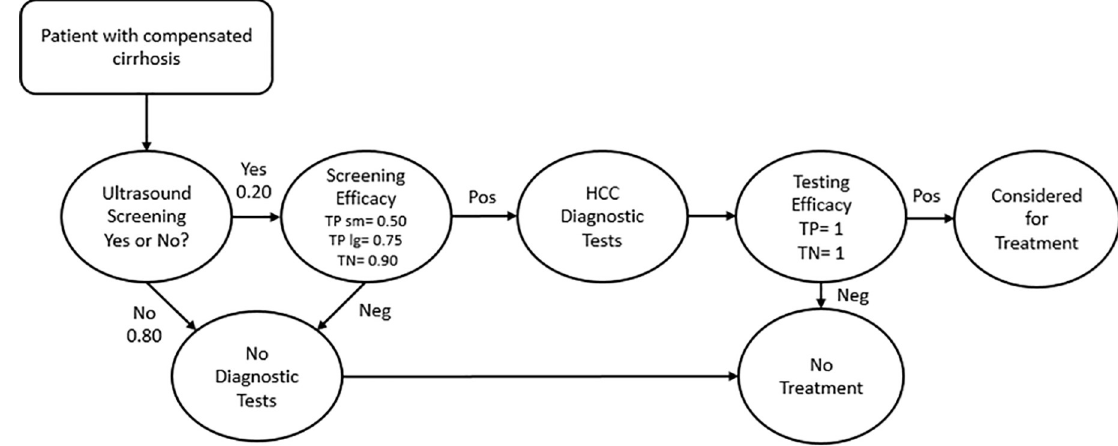
Fig 3. Surveillance, testing, and treatment consideration process modeled. HCC = hepatocellular cancer, TP sm = True positive for small tumors, TP lg = True positive for large tumors, TN = true negative. Those who receive a negative HCC test result re-enter